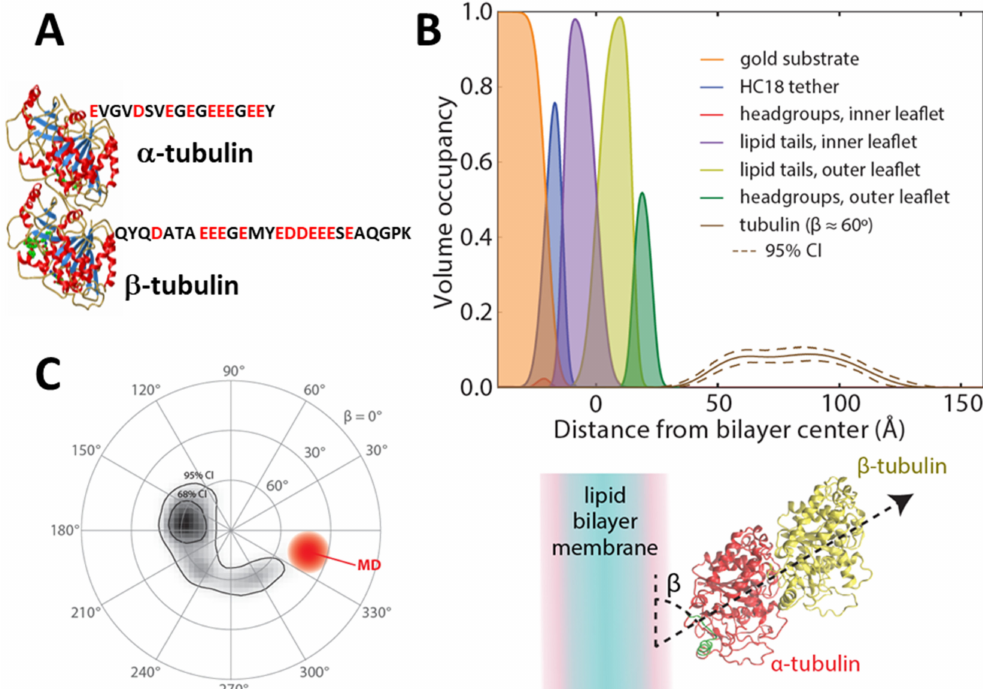
Figure 2. Structural properties of solubilized dimeric tubulin. ( A ) Crystal structure of tubulin (PDB ID: 1TUB) with the sequences of α 1 and β 3 C-terminal tails. ( B , C ) Orientation of peripherally membrane-bound tubulin as determined by neutron reflectometry and molecular dynamics simulations. ( B ) Volume occupancy of the molecular components of the lipid bilayer (filled curves) and membrane-bound tubulin described by Euler rotations of the crystal structure. The solid line shows the median volume occupancy of tubulin; the dashed lines show the 95% confidence interval. ( C ) Orientation plot of the Euler angles describing the rotation of the crystal structure to match the measured structure on the lipid surface. Both neutron reflectometry and molecular dynamics (MD) show an angle β between the dimer axis and the lipid surface of approximately 60 ◦ . CI = confidence interval. Adapted with permission from Hoogerheide et al., Proc. Natl. Acad. Sci. USA (2017). Copyright (2017) National Academy of Sciences. Table 1. Carboxy-terminal tail (CTT) sequences of human and yeast α - and β -tubulin isotypes, starting from the end of helix 12 at residue 430 [41], and α -synuclein. The negatively charged residues are highlighted in red. The total negative charge in the CTT includes the carboxyl group from the final amino acid. Adapted with permission from Rostovtseva et